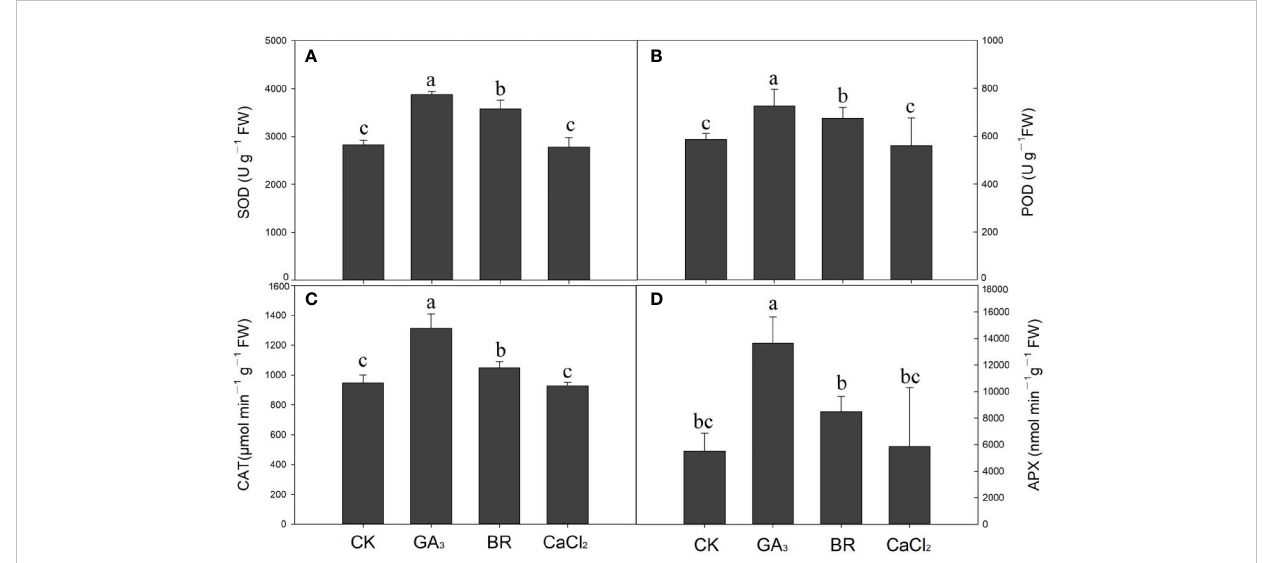
FIGURE 4 Response of antioxidant enzymes activities such as (A) Superoxide dismutase (SOD), (B) peroxidase (POD), (C) Catalase (CAT), and (D) Ascorbate peroxidase (APX) activities to various seed priming treatments under chilling stress. Lowercase letters indicate signi fi cant differences (P< 0.05) among the treatments. Bar shows standard error.